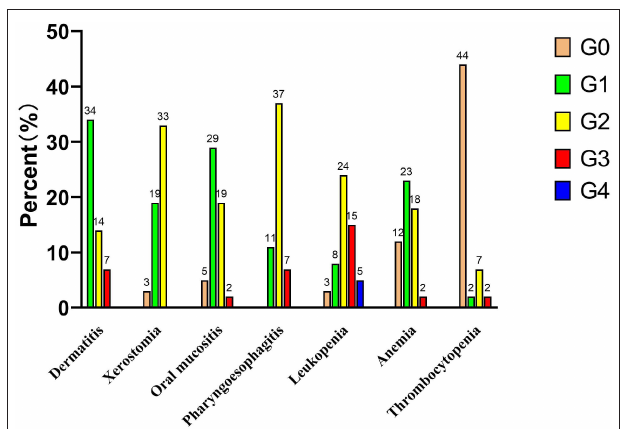
FIGURE 1 | Acute toxicities ( n =